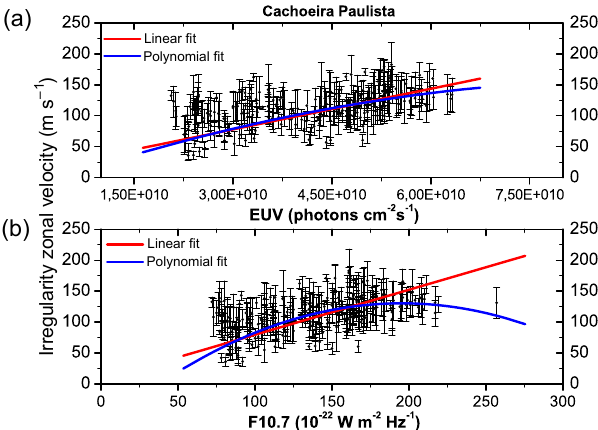
Figure 5. Linear fit (red line) and polynomial fit (blue line) of the daily mean zonal drift velocity of the irregularities estimated at Ca- choeira Paulista from 22:00 to 24:00LT versus daily values of the EUV flux (a) and F10.7 index values (b)